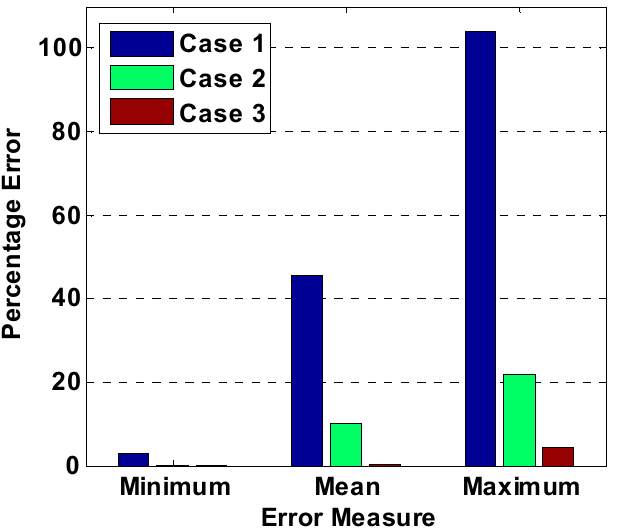
Figure 8. Comparison between error measures for different design cases.